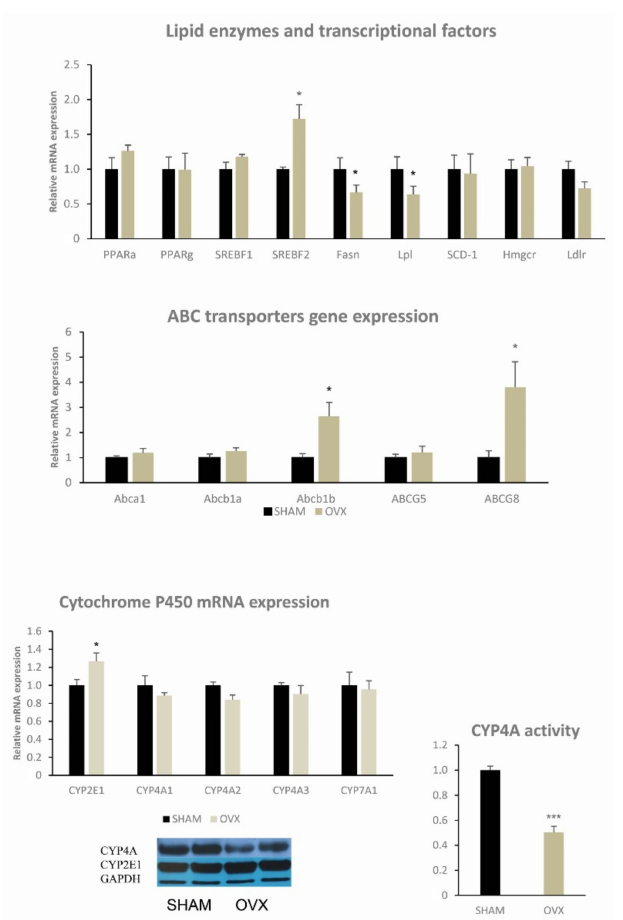
Figure 4. Relative mRNA expression of enzymes and transcriptional factors involved in lipid metabolism and ABC transporters in the liver. Relative mRNA expression, proteins and activity of some CYP450 family proteins in the liver in ovariectomized Wistar female rats compared to sham-operated con- trols. Significance was determined using the unpaired Student’s t test (* denotes p < 0.05, *** denotes p < 0.001); PPAR—peroxisome proliferator-activated receptor, SREBF—sterol regulatory element-binding protein, FAS—fatty acid synthase, LPL—lipoprotein lipase, SCD1—stearoyl CoA desaturase-1, HMGCR— hydroxyl-methyl-glutaryl-CoA reductase, LDLR—low-density lipoprotein